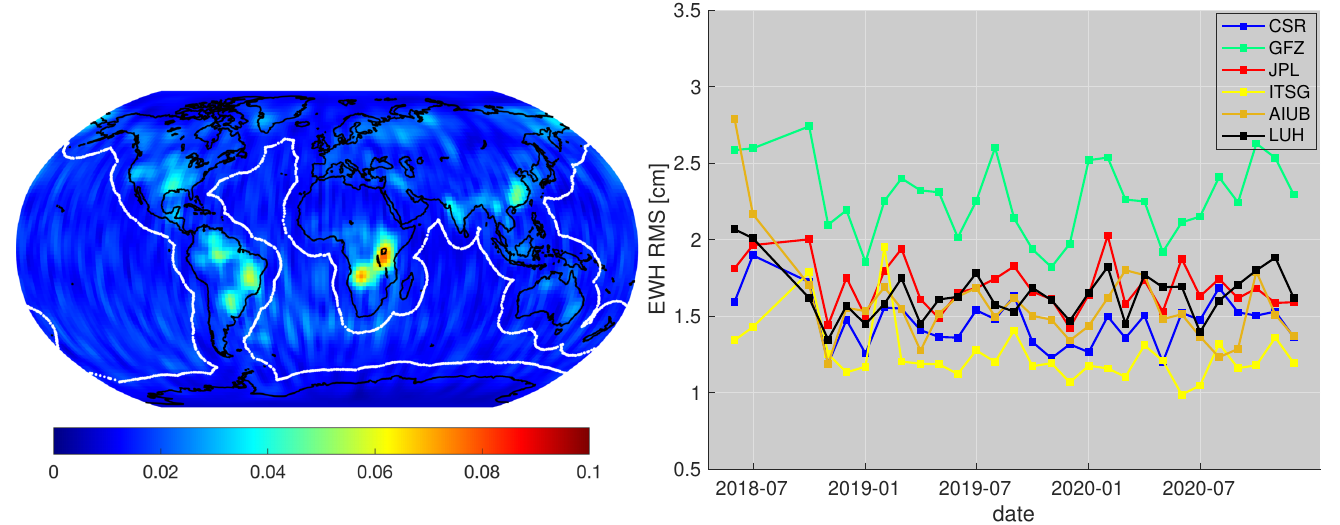
Figure 2. Left panel: Residual EWH signal of the LUH solutions after subtracting a model consisting of bias, trend, annual and semi-annual variations. White lines represent the applied ocean mask. Units of the color bar: m. Right panel: RMS of residual EWH signal over the oceans. C 20 and C 30 coefficients are replaced with SLR values. Gaussian filter with a 400 km averaging radius